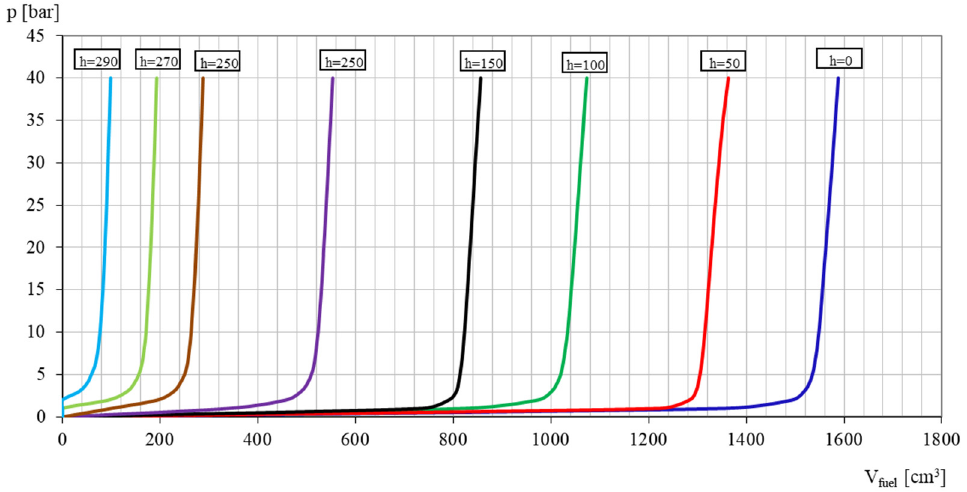
Figure 9. Change in the pressure in the measured volume at predefined piston positions for the 10% content of CO 2 in the exhaust gas.